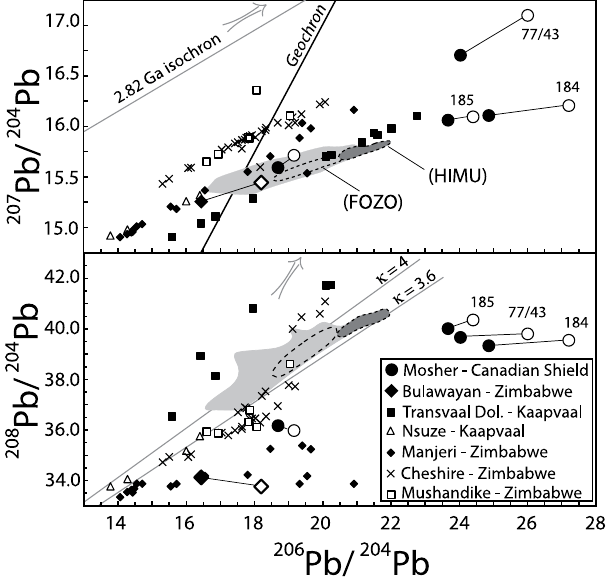
Figure 1. 206 Pb/ 204 Pb versus A. 207 Pb/ 204 Pb and B. 208 Pb/ 204 Pb for Archaean limestones. Bulk stromatolitic limestones (solid symbols) are connected by tie lines to their respective carbonate fractions (open symbols). Analytical errors are smaller than the symbols used. Shown for reference are the carbonate fractions of other Archaean limestones (see text for sources of data), oceanic basalts (gray field), FOZO (dash area inside gray field), and HIMU end-component (dark gray field). The 2.82 Ga isochron in A. is the regression line for the extremely radiogenic ( 206 Pb/ 204 Pb = 30.2 to 104.4; 207 Pb/ 204 Pb = 19.4 to 34.1; 208 Pb/ 204 Pb = 42.514 to 74.402) Mushandike stromatolites 24 (not